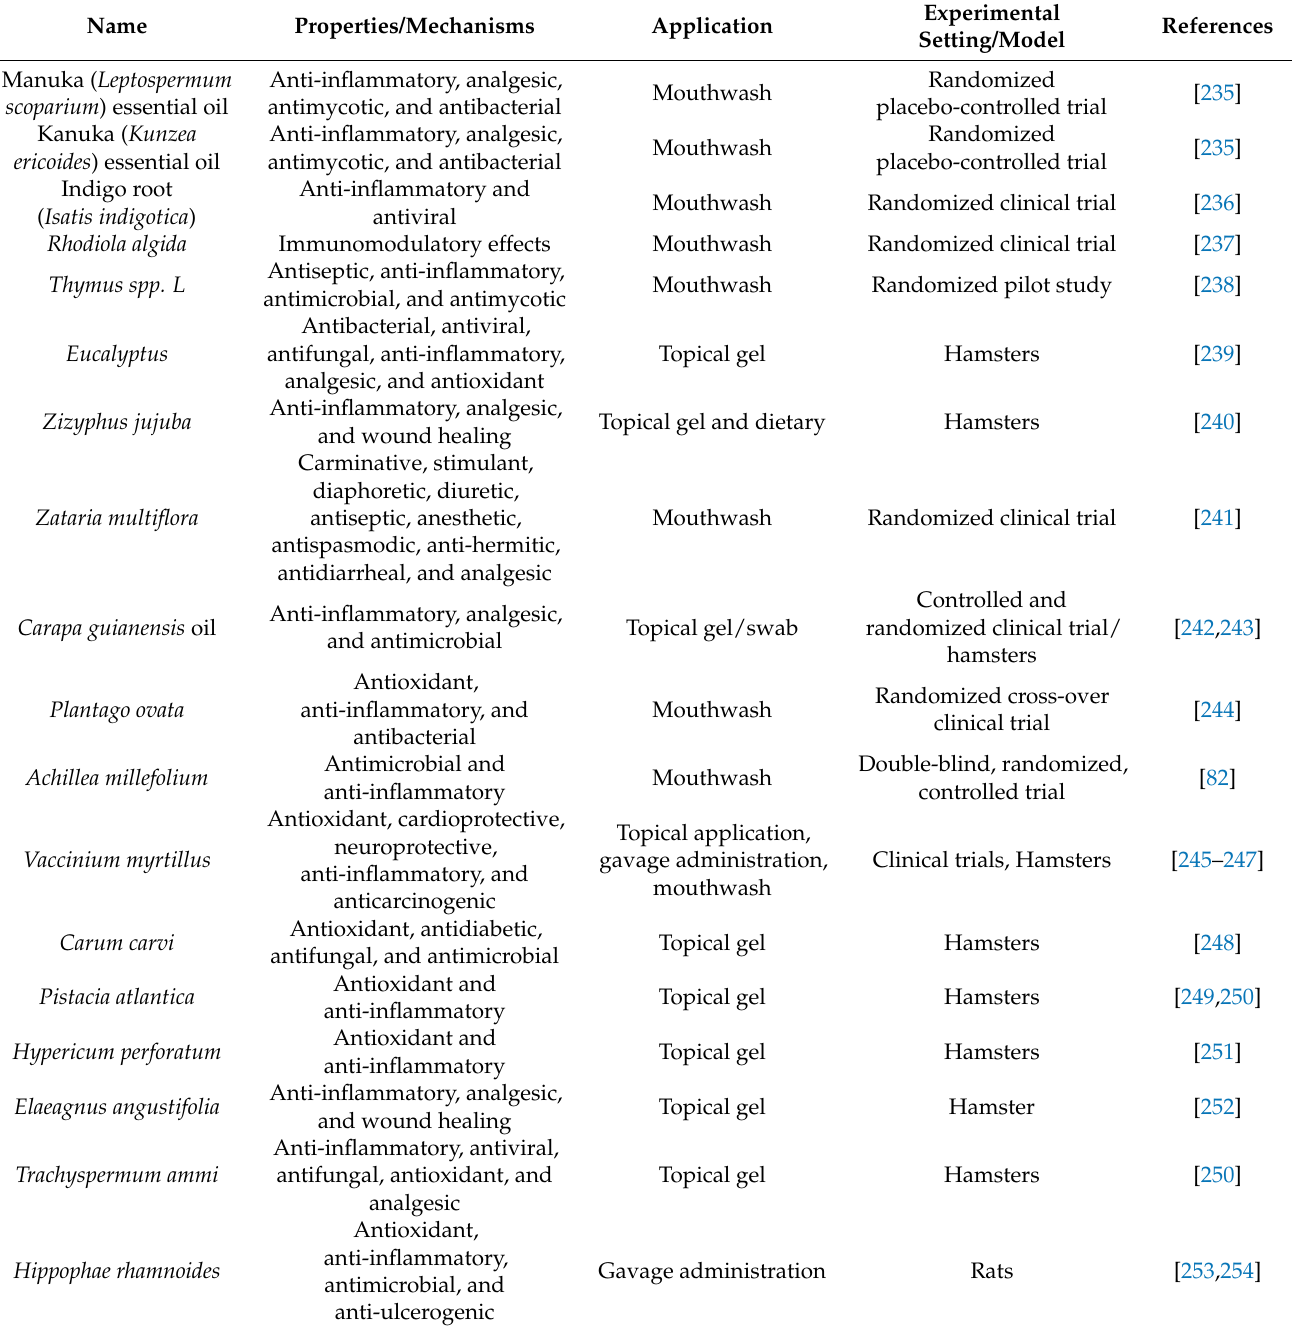
Table 4. Summary of studies with natural products for prevention/treatment of oral